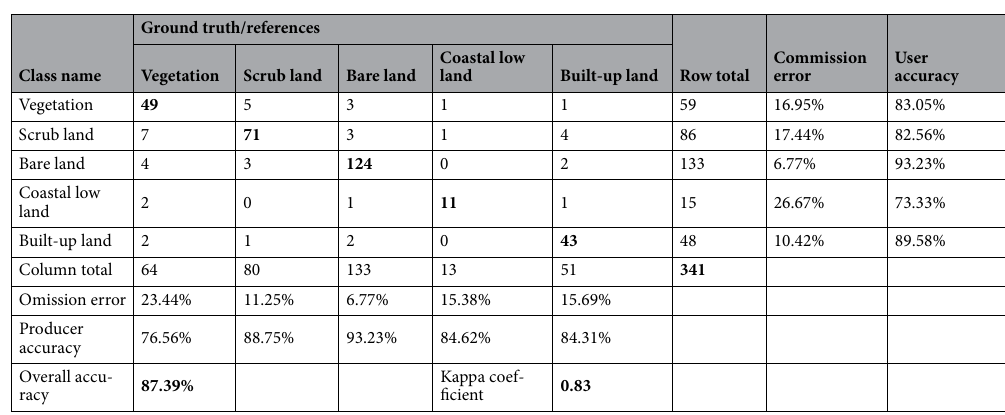
Table 8. Accuracy assessment and kappa coefficient for the year of 2020. The [bold] value is necessary to identify the accuracy assessment and kappa